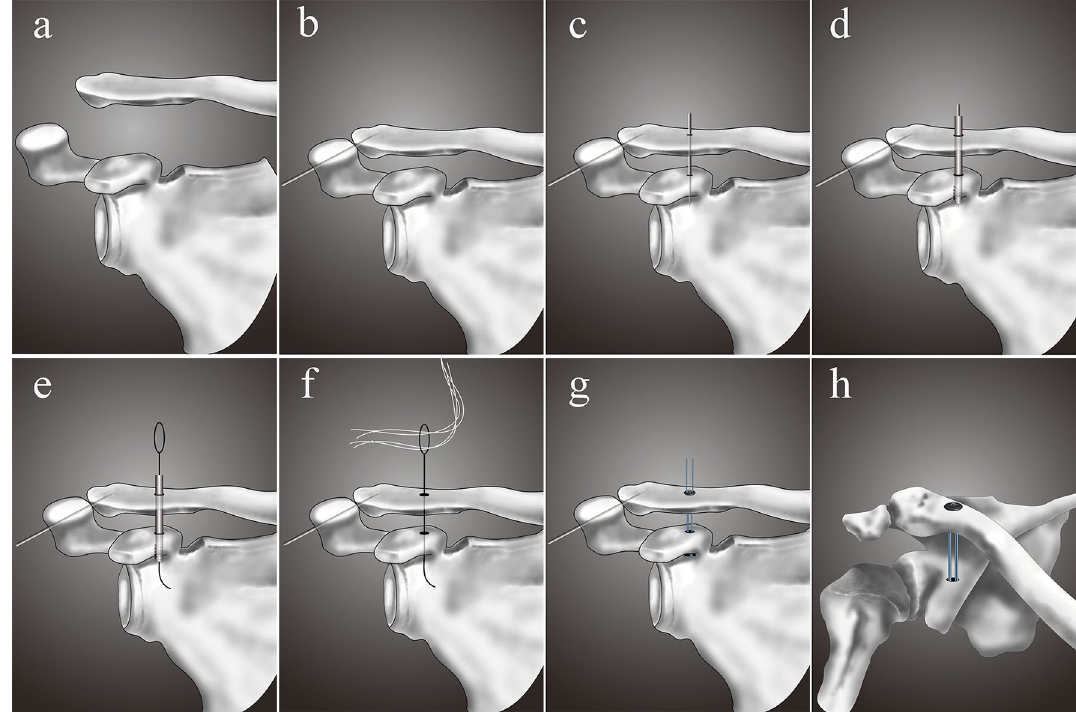
Figure 2. MITR operative procedure. ( a ) AC joint dislocation. ( b ) Closed reduction and fixation of AC joint dislocation with a Kirschner wire. ( c ) A 2.0-mm Kirschner wire is introduced through the clavicle and coracoid. ( d ) A 4.0-mm drill bit is drilled into the base of the coracoid. ( e ) A nitinol suture passing wire is advanced down through the cannulated drill bit. ( f ) The drill bit is removed, and the two white traction sutures are inserted into the bone tunnels through the wire loop of the nitinol suture passing wire. ( g ) The TR system is introduced, and the reduction and stabilization of the AC joint are completed. ( h ) Final frontal view of AC joint fixed with the TR